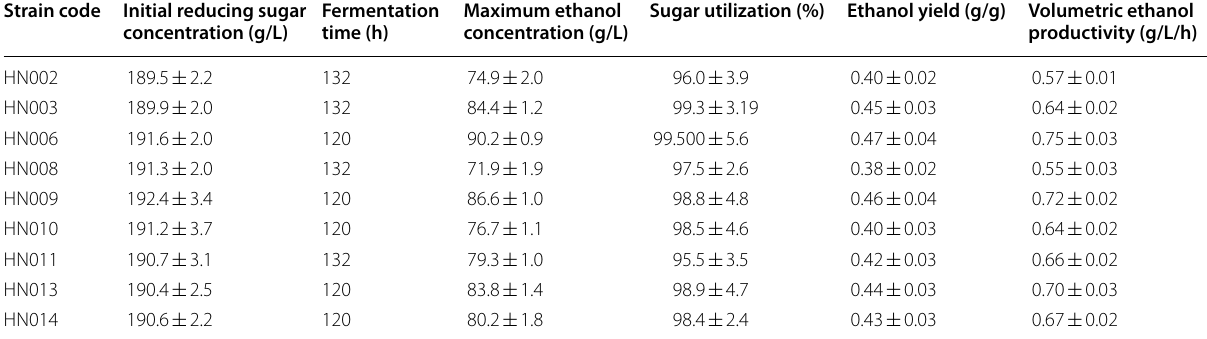
Table 3 Evaluation of kinetic parameters for Chinese chestnut wine by various yeast strains Strain code Initial reducing sugar concentration